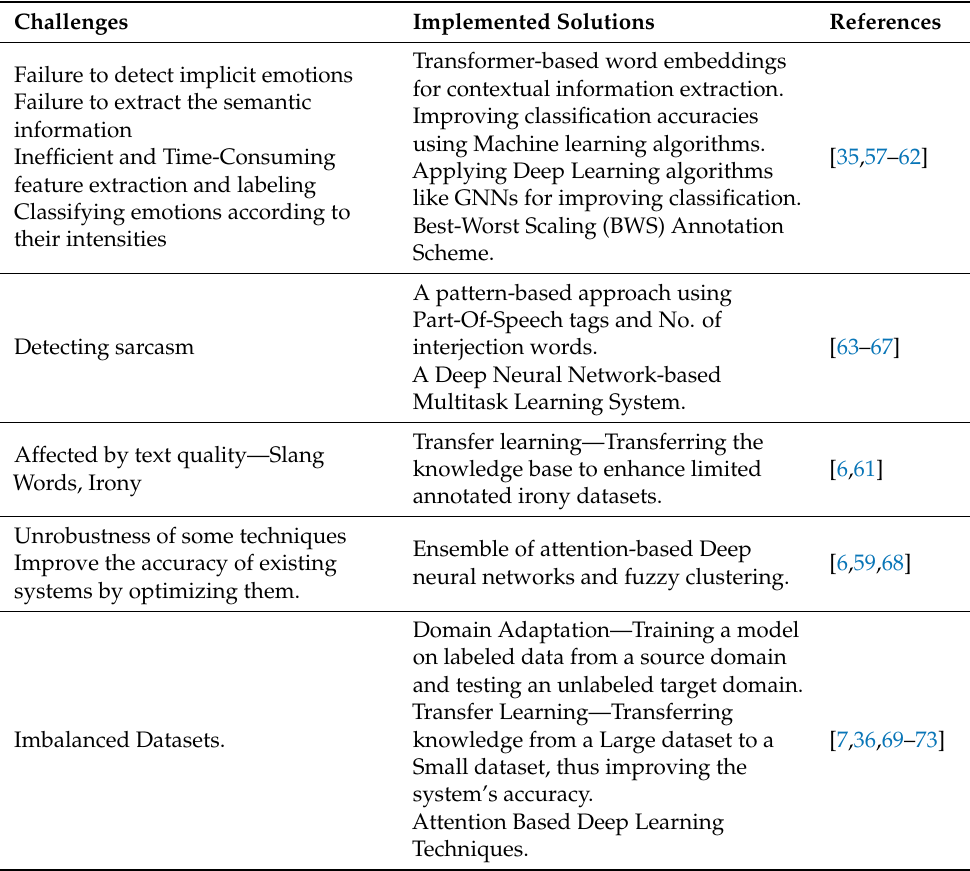
Table 24. Challenges identified from the Qualitative